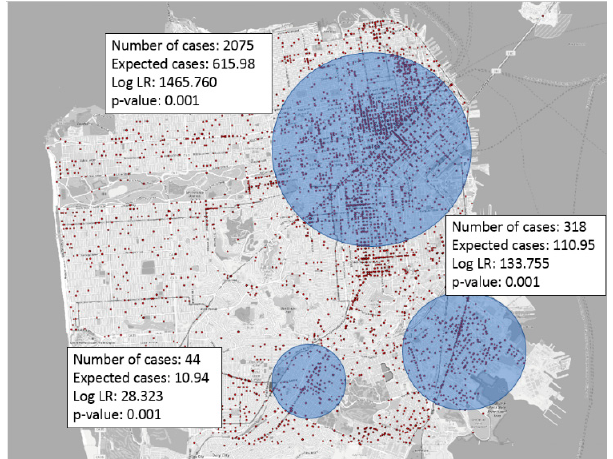
Figure 1. Crime hotspots detected by SaTScan. The point dataset contains 3781 cases of assault crimes in San Francisco, 2017. The map shows three statistically significant hotspots in